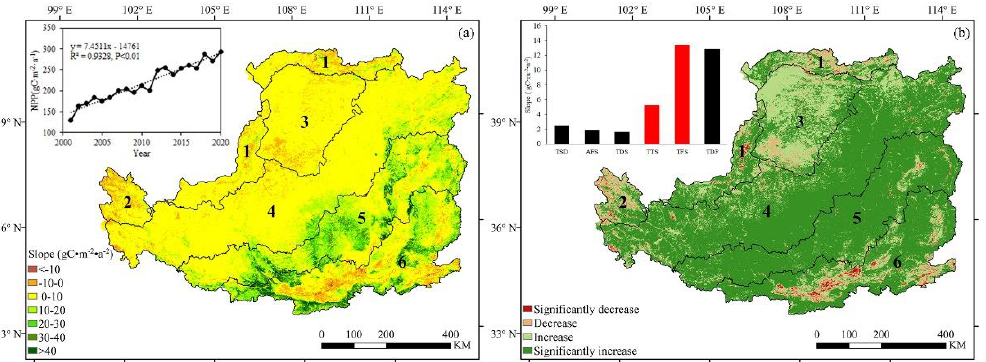
Figure 3. NPP distribution in ( a ) 2001 and ( b ) 2020 on the Loess plateau. The numbers on the pixels represent six sub-regions on the LP: (1) temperate steppe desert (TSD), (2) alpine forest – steppe (AFS), (3) temperate desert – steppe (TDS), (4) temperate typical steppe (TTS), (5) temperate forest – steppe (TFS), (6) temperate deciduous forest (TDF). Bar charts show the average NPP in six sub-regions in 2001 and 2020.